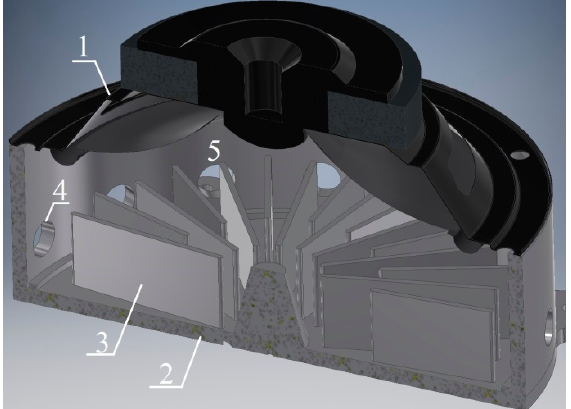
Figure 2. The cross section of SJA with integrated heat sink, 1, loudspeaker; 2, heat sink base; 3, fin; 4, orifice; 5, cavity.